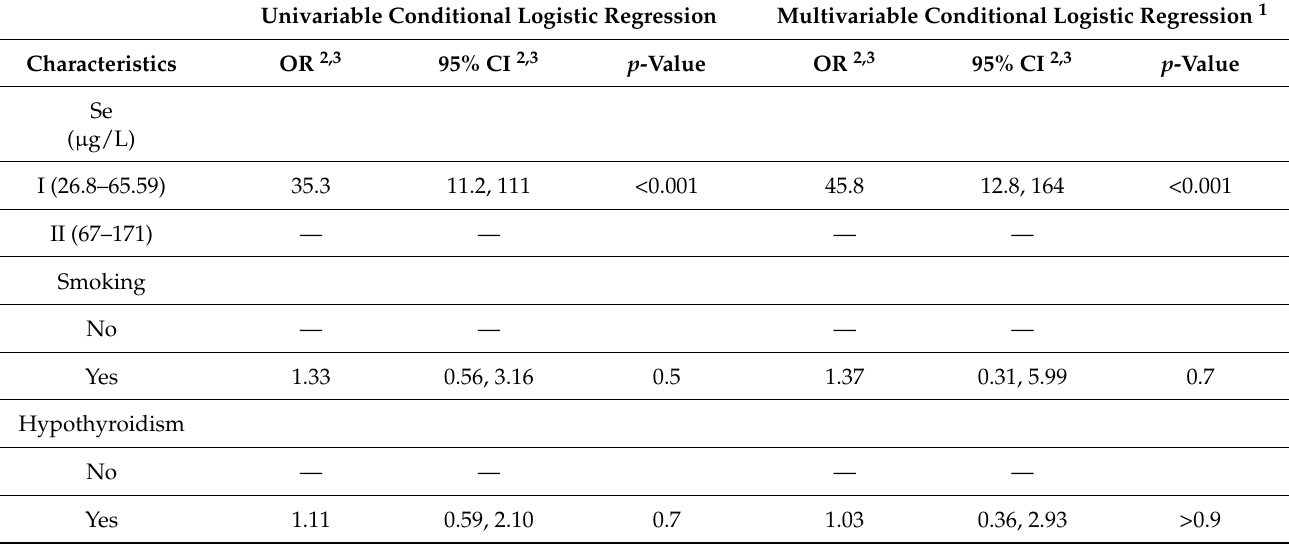
Table 2. Statistical results for the entire study population. Univariable Conditional Logistic Regression Multivariable Conditional Logistic Regression